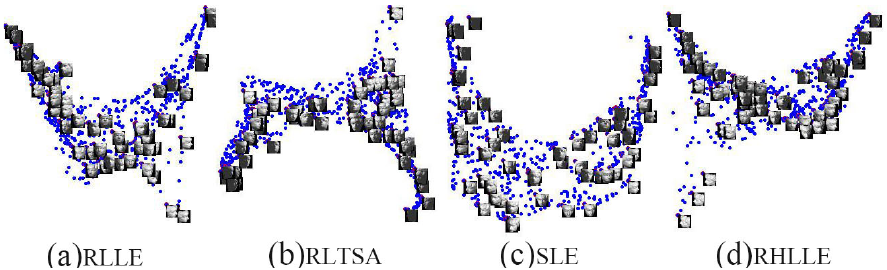
Figure 11. 2D embedding results of RLLE, RLTSA, SLE and RHLLE on the original ISOFACE image set without being corrupted.